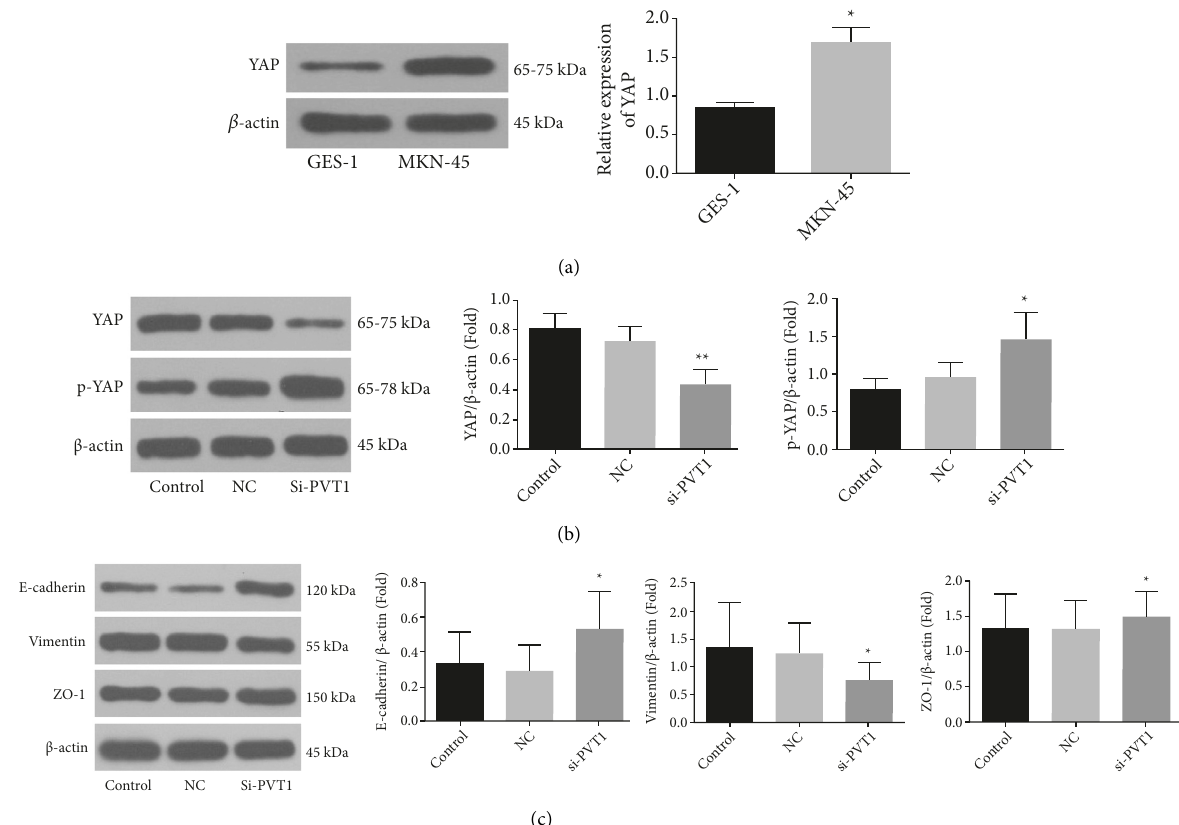
Figure 4: Knockdown of PVT1 inhibits the expression of YAP and EMT